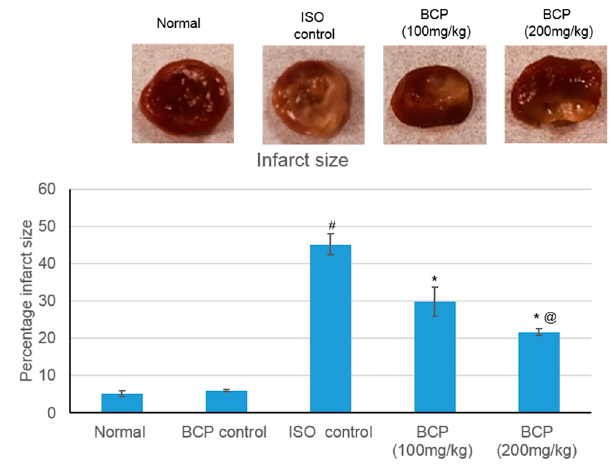
Figure 2. Representative pictures of the TTC-stained rat-heart slices showing the effects of β -caryophyllene treatment (100, 200 mg/kg) for 21 days on myocardial infarction size in ISO-induced myocardial infarction. All values were expressed as mean ± SD ( n = 6). ISO: isoproterenol; BCP: β -Caryophyllene; TTC: triphenyl tetrazolium chloride. # indicates statistically significant from normal group, * indicates statistically significant from isoproterenol group, @ indicates statistically significant from β -caryophyllene (100 mg/kg) group ( p < 0.05) using one way ANOVA followed by Tukey’s test as a post-hoc analysis.